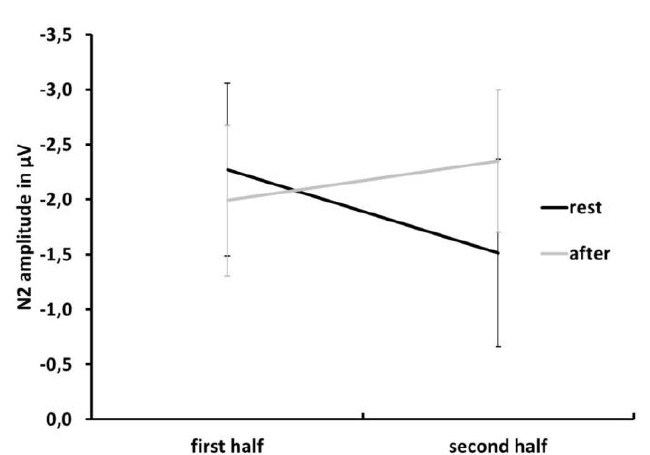
Figure 5. Mean N2 peak amplitude at rest (black) and after exercise (grey) trials in the first and second half of the dataset to visualize the test time × half interaction. Note: Negativity is plotted upward. Error bars depict standard error values.